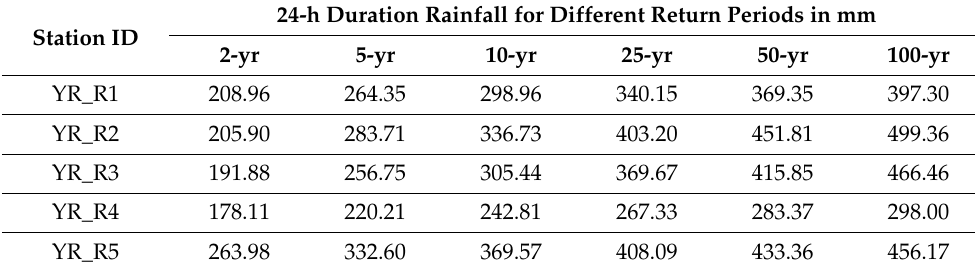
Table 1. Calculated 24-h rainfall values at five stations for different return periods. Station ID